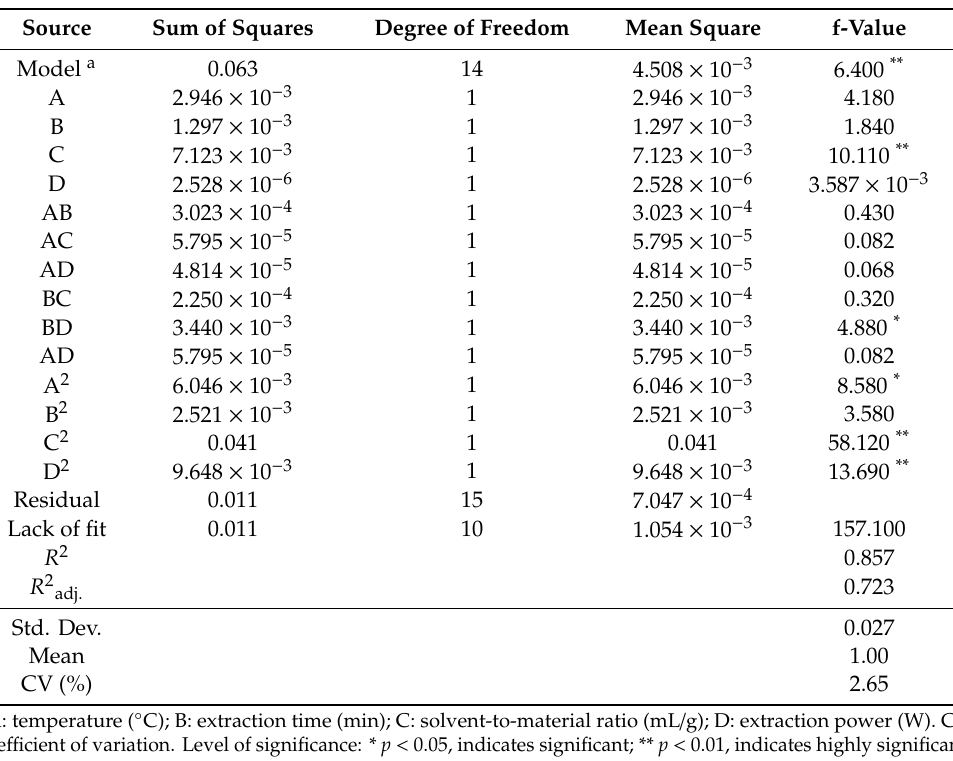
Figure 3. Response surfaces of the comprehensive evaluation value of HSYA and AHSYB yield: ( a ) Temperature (A) and Extraction time (B); ( b ) Temperature (A) and Solvent-to-material ratio (C); ( c ) Temperature (A) and Extraction power (D); ( d ) Extraction time (B) and Solvent-to-material ratio (C); ( e ) Extraction time (B) and Extraction power (D); and ( f ) Solvent-to-material ratio (C) and Extraction power (D). 2.4. Optimal Processing Conditions and Verification of the Predictive Model An extraction temperature of 66.28 °C, extraction time of 35.62 min, solvent-to-material ratio of 15.62 mL/g, extraction power of 151.15 W, and a comprehensive evaluation value of 1.07 represented the optimal conditions for maximizing the extraction yields of HSYA and AHSYB. The experimentation was facilitated by slightly modifying the parameters in the verification experiments as follows: extraction temperature of 66 °C, extraction time of 36 min, solvent-to-material ratio of 16 mL/g, and extraction power of 150 W. All the experiments conducted under the optimized conditions were performed in quadruplicate and the results are depicted in Table 2. The results demonstrated that the actual values were close to the predicted values, which indicated that the model thus generated was the best model. Table 2. Verification test under optimized conditions from the response surface. Extraction Yield (%)